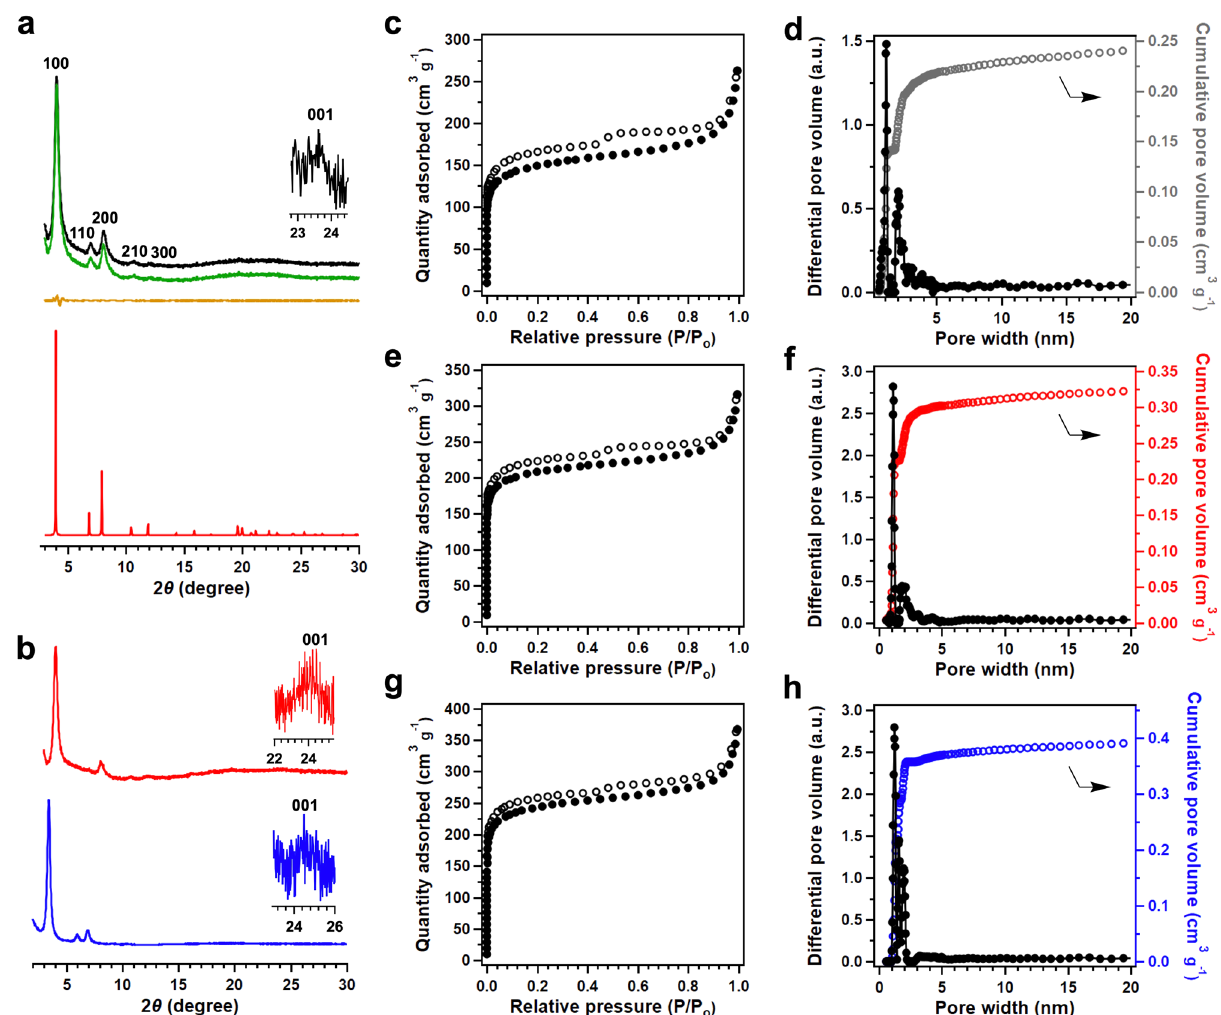
Fig. 2 PXRD and Porosity. a PXRD patterns of HFPTP-DMePDA-COF (black curve), the Pawley re fi nement result (green curve) and their difference (yellow curve) and the AA-stacking mode of the P 3 space group (red curve). b PXRD patterns of HFPTP-PDA-COF (red curve) and HFPTP-BPDA-COF (blue curve). c , Nitrogen sorption isotherm of HFPTP-DMePDA-COF. d Pore size distribution and pore volume of HFPTP-DMePDA-COF. e Nitrogen sorption isotherm of HFPTP-PDA-COF. f , Pore size distribution and pore volume of HFPTP-PDA-COF. g Nitrogen sorption isotherm of HFPTP-BPDA-COF. h Pore size distribution and pore volume of